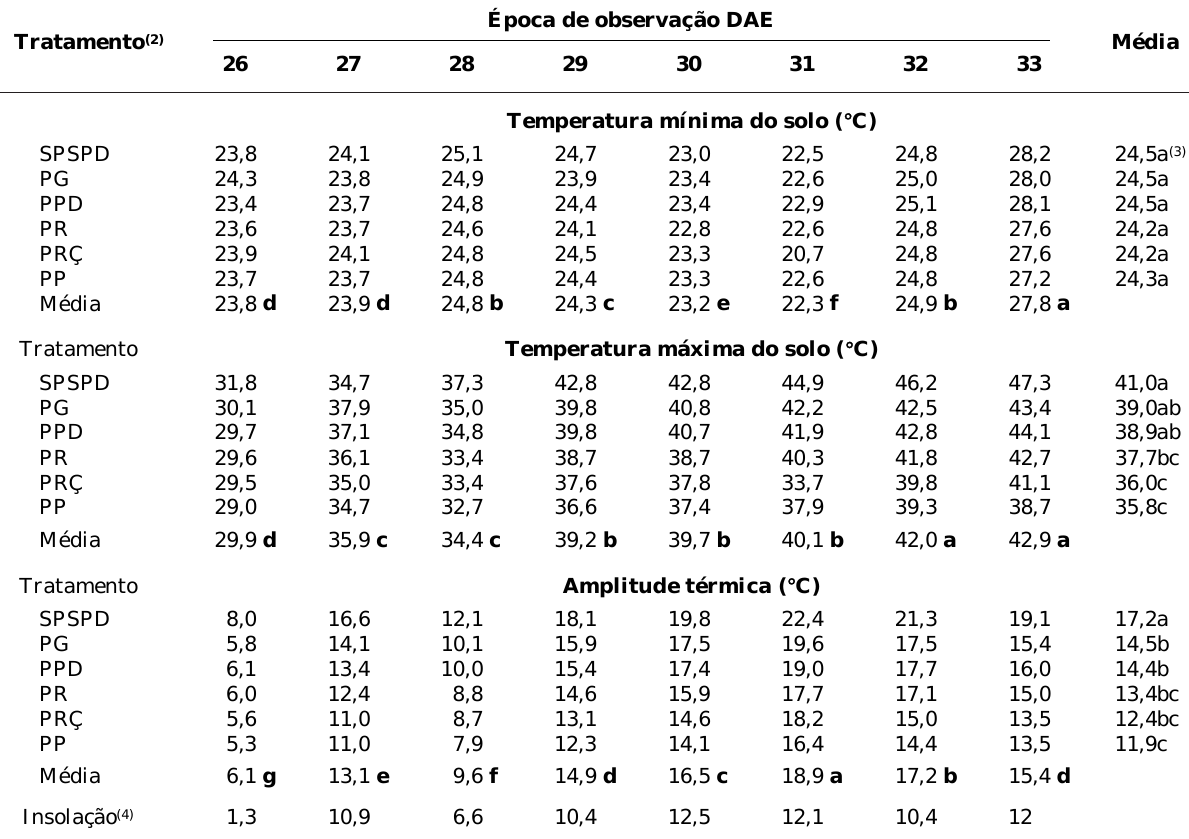
(1) DAE = dias após emergência. (2) Tratamentos: SPSPD- Sem palha sem plantas daninhas; PG- Palha gradeada; PPD- Palha picada e distribuída; PR- Palha rolada; PRÇ- Palha roçada; PP- Palha em pé. (3) Médias seguidas da mesma letra não diferem pelo teste de Duncan a 5%. (4) Insolação = período de luz solar em